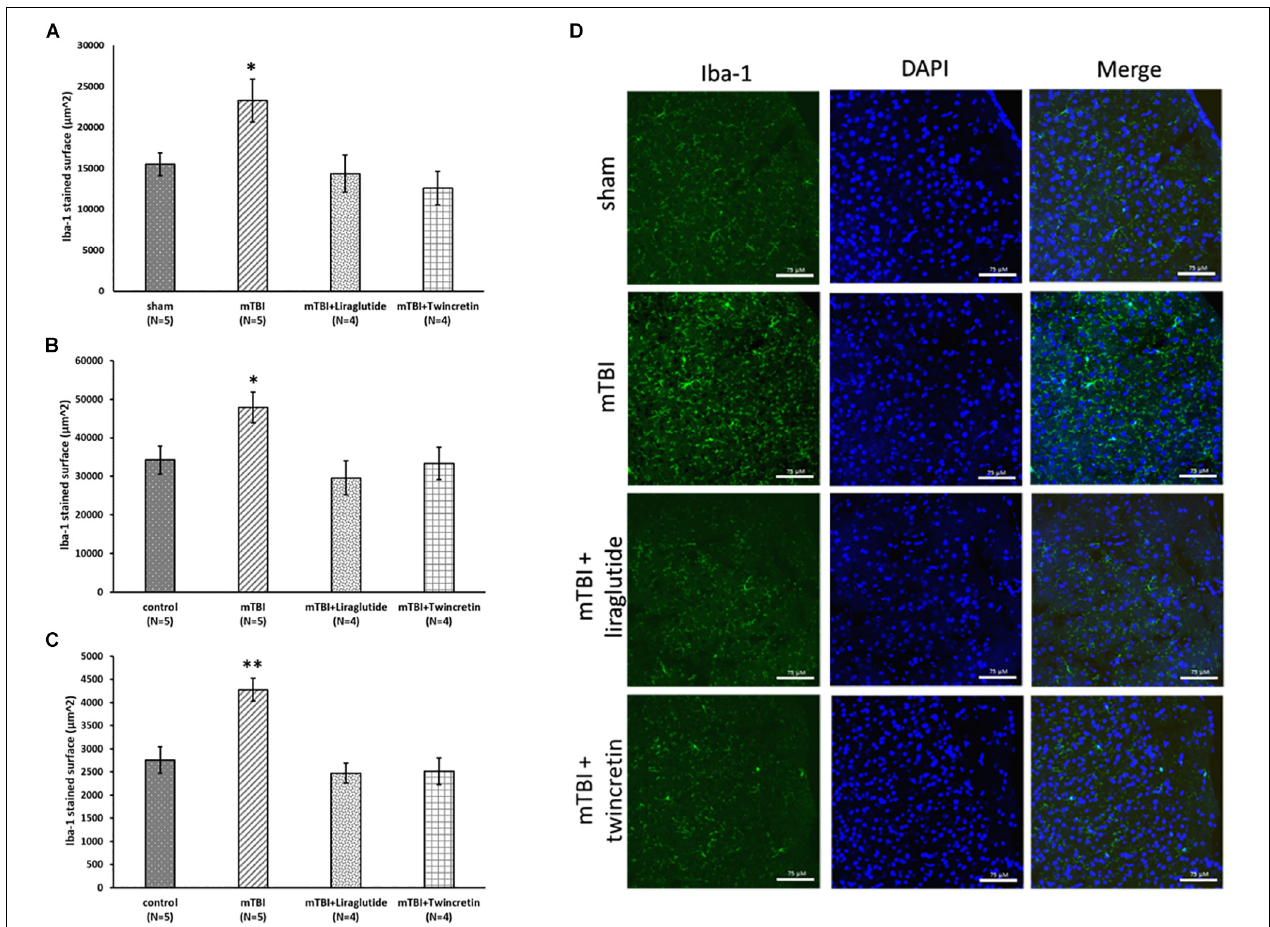
FIGURE 6 | Liraglutide and twincretin treatments reduce the mTBI-induced elevation in activated microglia expression, 72 h post trauma. Graphs presenting quantification of the total surface labeled with Iba-1 in the temporal cortex (A) , CA3 region (B) , and the dentate gyrus (C) . One-way ANOVA followed by Fisher’s LSD post hoc analysis demonstrated that mTBI induction led to a significant elevation in Iba-1 expressing cells compared to sham tissues in all regions tested [ A: F (3,14) = 5.117; p < 0.05, B: F (3,14) = 4.060; p < 0.05, and C: F (3,14) = 11.102; p < 0.01, ∗ p < 0.05 in the cortex and CA3 and ∗∗ p < 0.01 in the dentate gyrus]. Treatment with either liraglutide or twincretin following mTBI induction attenuated this elevation as compared to mTBI with no treatment. Values are mean ± SEM. (D) Representative images of immunohistochemical staining in the temporal cortex are presented. Iba-1 positive cells are shown in green and DAPI positive cells are shown in blue. The scale bars are 75 µ